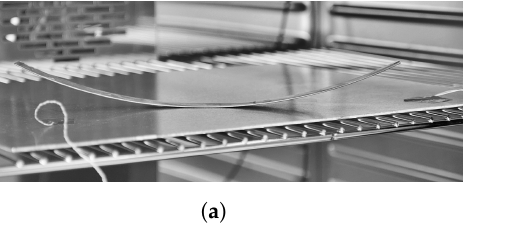
Figure 6. Stress-free temperature measurement through reheating of a specimen after manufacturing in a lab oven and determination of the temperature when the specimen reaches its flat state. ( a ) Curved specimen at room temperature; ( b ) Flat specimen at stress-free